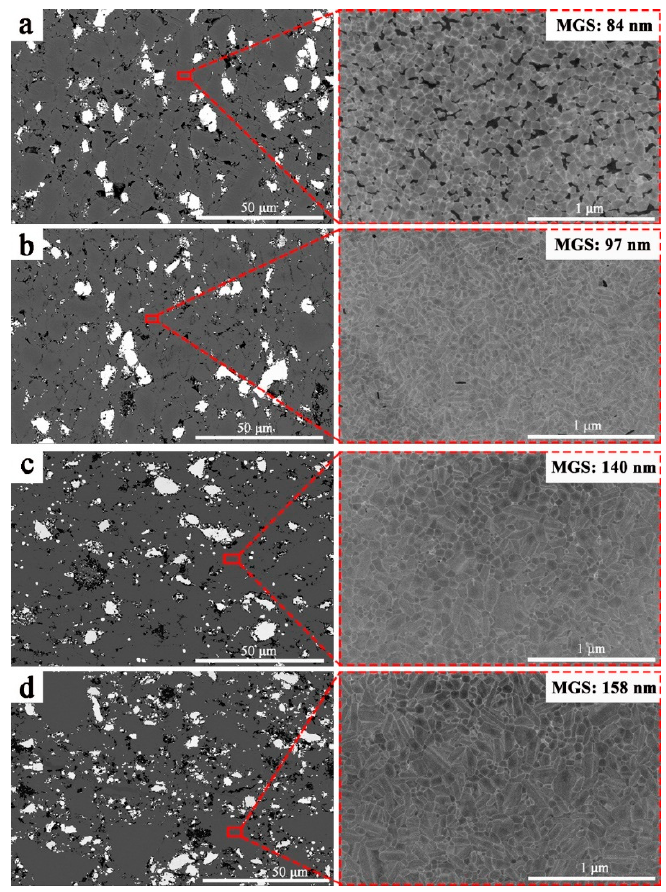
Figure 4. Scanning electron microscope (SEM) images of the polished surface after ion etching at different temperatures: 1950 °C ( a ); 2000 °C ( b ); 2050 °C ( c ); 2100 °C ( d ).